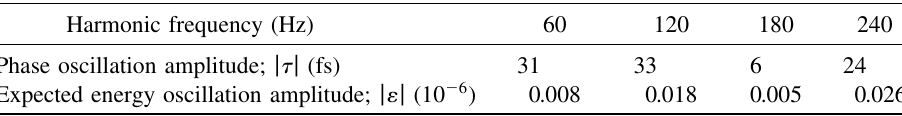
TABLE III. Ratio of sideband peak height to main peak height (carrier wave) in the FFT power